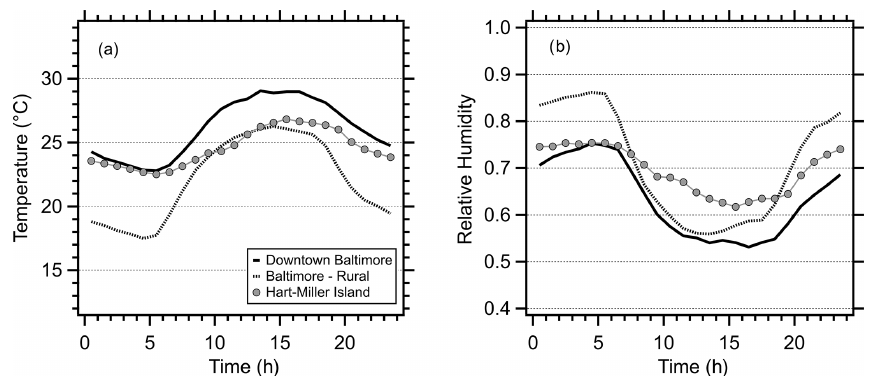
Figure 1. Diurnal profiles of (a) temperature and (b) relative humidity at three sites during the OWLETS-2 study. Hart-Miller Island (HMI) is a land–water transition site and was the location of aerosol composition and gas-phase measurements during the campaign. Temperatures at HMI resembled the downtown location during the night but showed characteristics of the rural site during the day. RH at HMI was between the urban and rural sites at night but was elevated during the daytime due to the Chesapeake Bay.